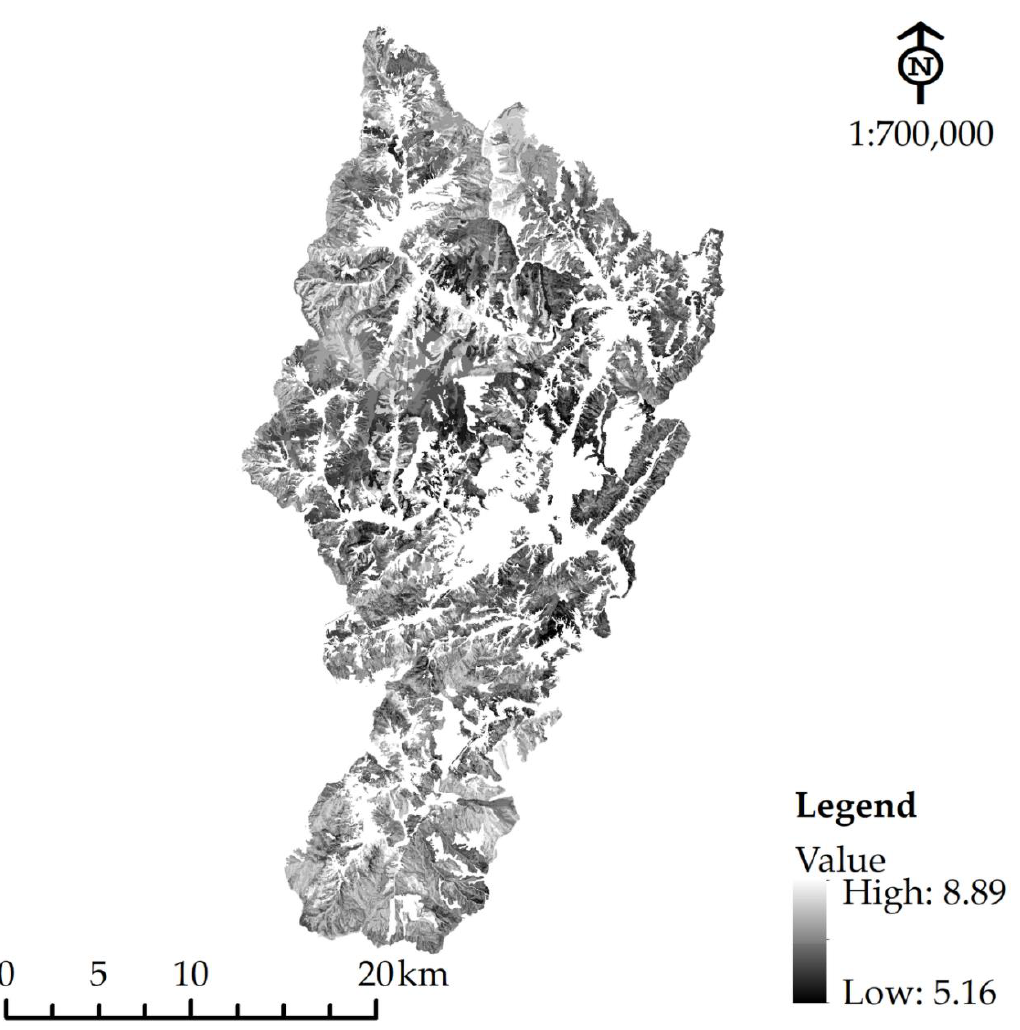
9 of 14 Figure 5. Thematic map for each growth factor of WSG using the forest soil map; ( a ) thematic map for soil organic content aspects within the study area; ( b ) thematic map for effective soil depth within the study area; ( c ) thematic map for soil texture within the study area; ( d ) thematic map for soil moisture with the study area; ( e ) thematic map for drainage within the study area.